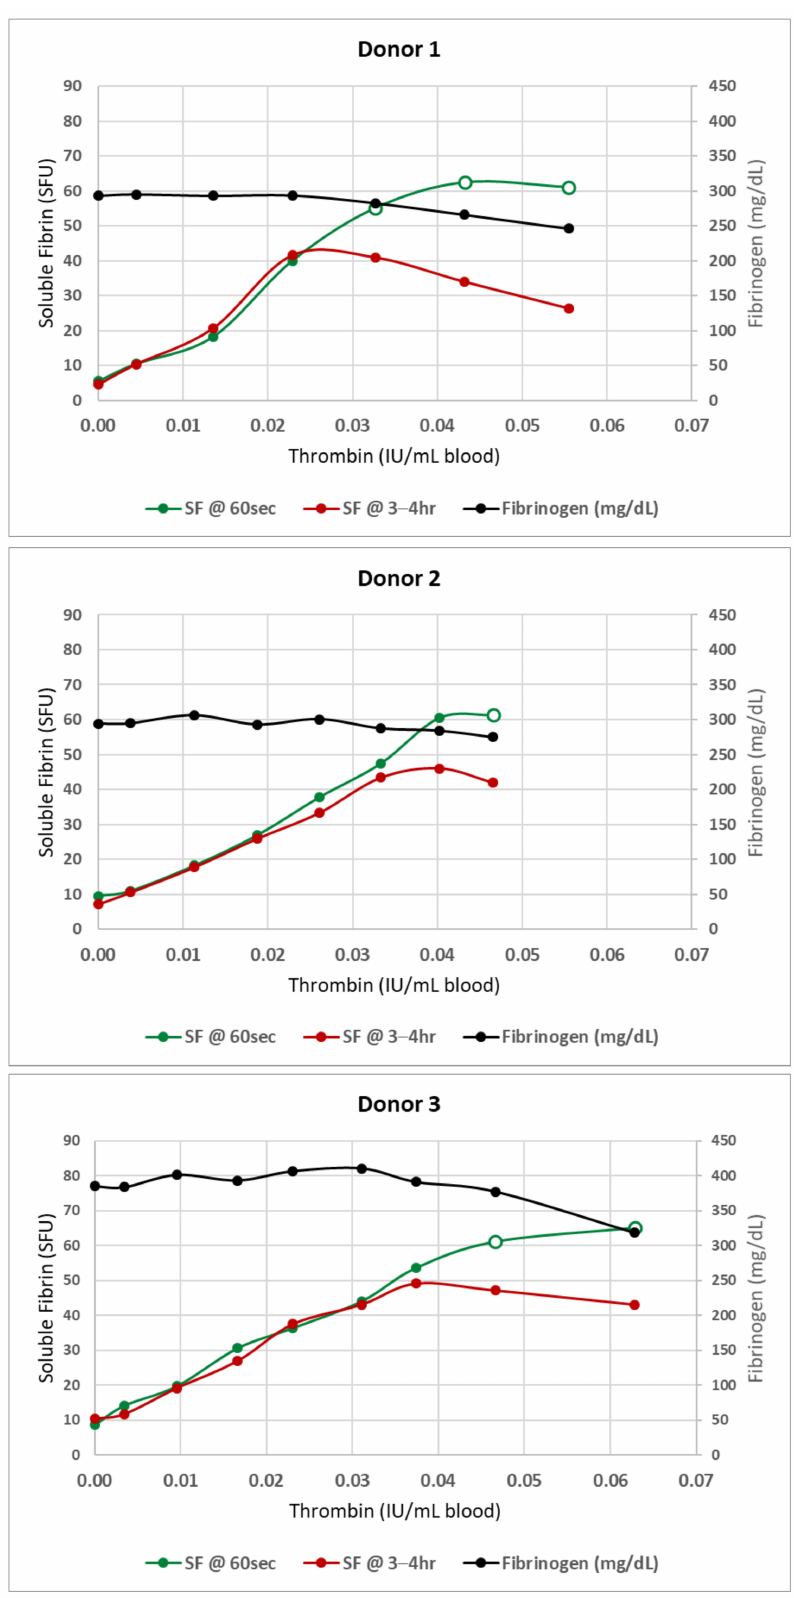
Figure 2. Plots similar to one previously published [32] showing the initial linear phase of stable soluble fibrin formation followed by a gradual bending of the curve (open circles) at which point soluble